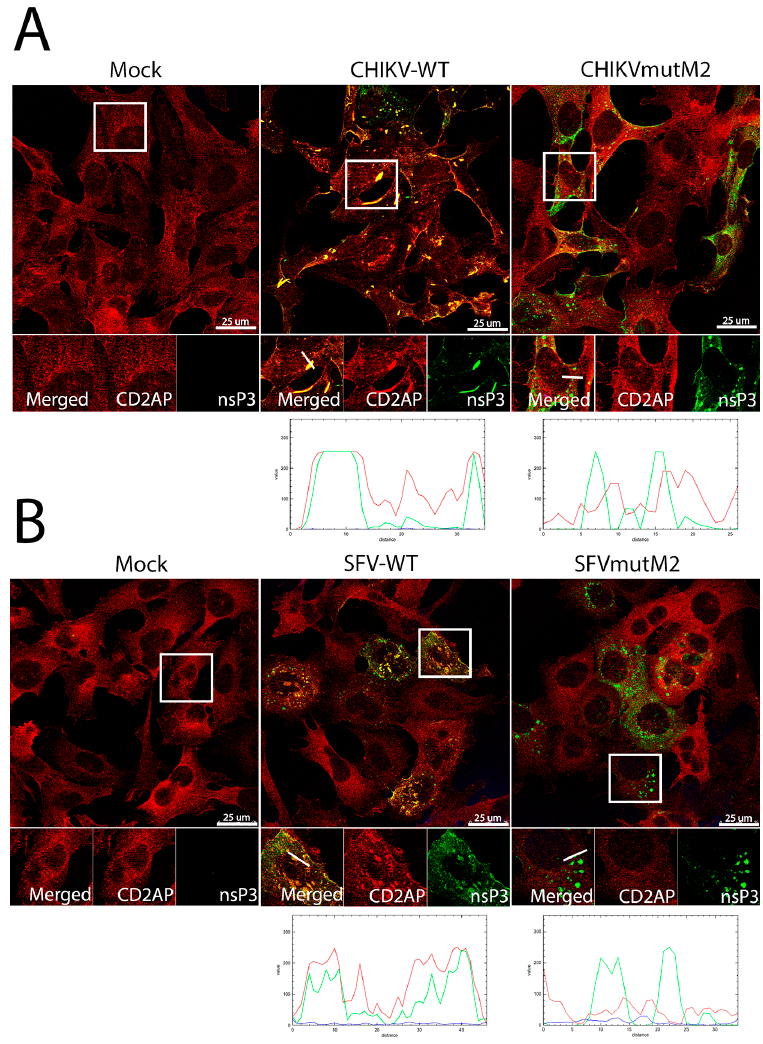
Figure 6. CD2AP co-localisation with CHIKV and SFV nsP3 in infected cells. HOS cells were infected with CHIKV wt or CHIKVmutM2 ( A ) or SFV wt or SFVmutM2 ( B ) at an MOI of 1. At 16 ( A ) or 8 h p.i. ( B ), cells were fixed and stained for nsP3 (green) and CD2AP (red), line scan images are given below the confocal images. Results are representative of three independent experiments.